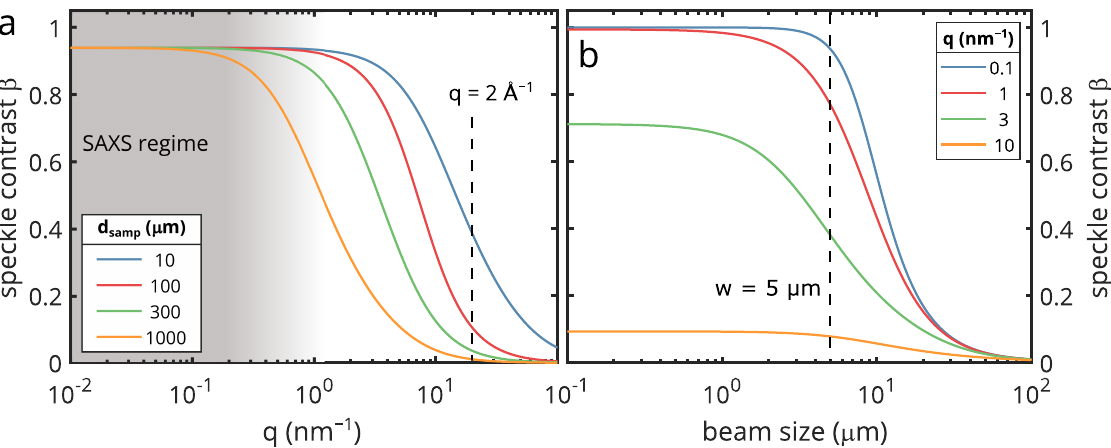
Figure 6. ( a ) Geometrical speckle contrast as a function of q for different sample thicknesses d samp . The beam size was set to 5 µ m, the dashed line marks a typical q -value for intermolecular distances. ( b ) Geometrical speckle contrast as function of beam size at different q values at d samp = 500 µ m. The dashed line marks a beam size of 5 µ m as used in the left side. In both parts the bandwidth was set to 1.4 × 10 − 4 , the sample-detector distance to 5 m, X-ray energy was 10 keV, and the pixel size 75 µ